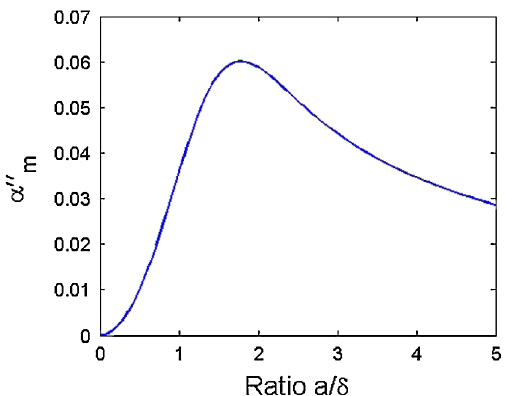
FIG. 2. (Color) Imaginary part of the magnetic polarizability of a small cylinder oriented perpendicularly to the direction of the magnetic